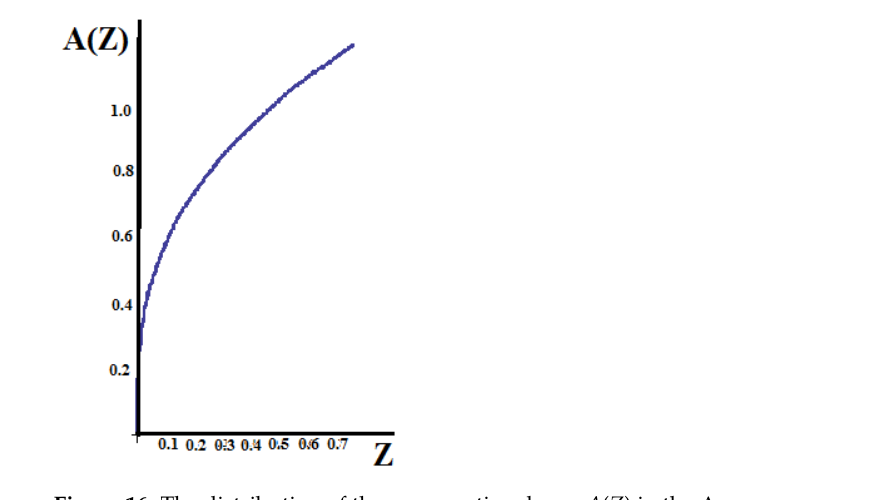
Figure 16. The distribution of the cross-sectional area A ( Z ) in the Λ -space. Further, the length of the bar l in the initial space becomes L in the fractional Λ -space through Equation (24). The axial force p applied at the right end of the bar corresponds to the P load in the Λ -space defined by Equation (23). In addition, Young’s modulus of elasticity E corresponds to E Λ defined by Equation (25).